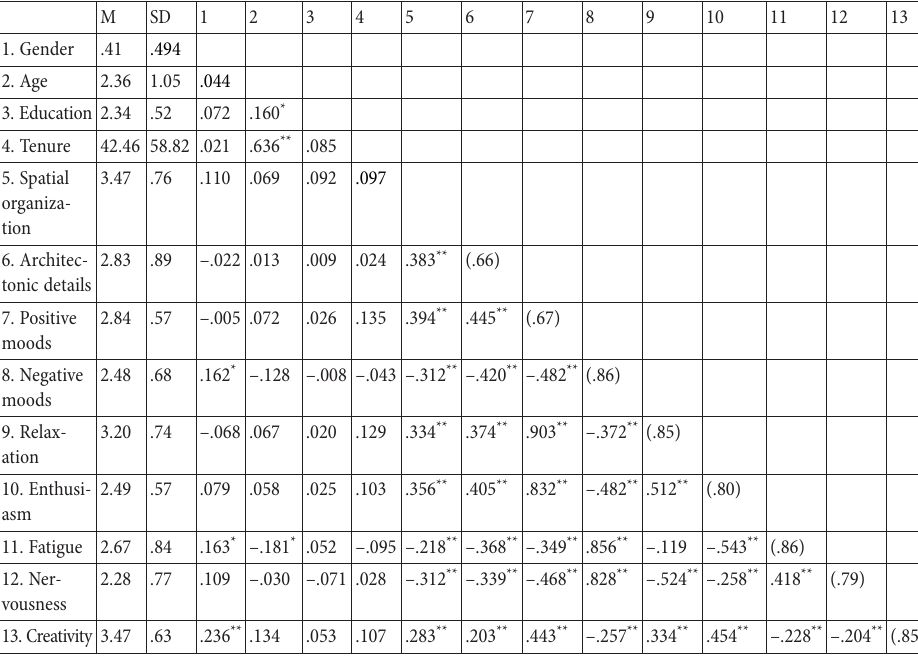
Table 1. Descriptive statistics and correlation (source: created by